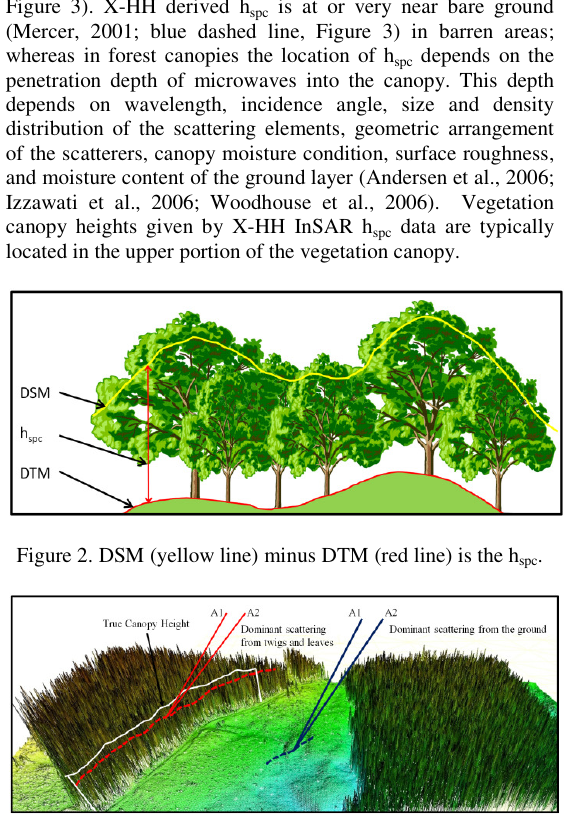
Figure 3. Relative position of X-HH InSAR h spc for a dense forest, bare ground, and true canopy height (red, blue and white dashed lines, respectively .